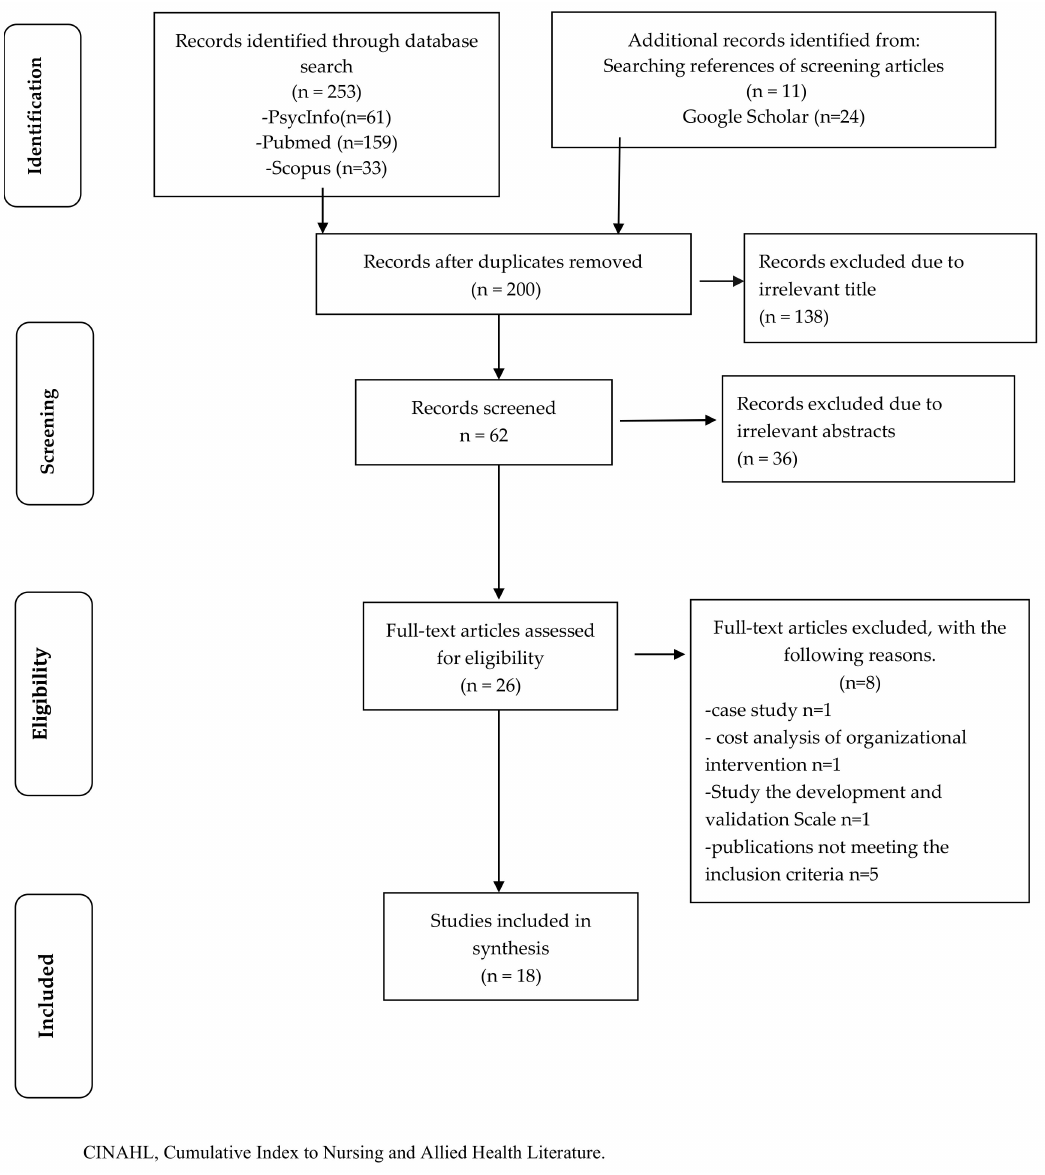
Figure 1. Flow chart illustrating the selection process of scoping review